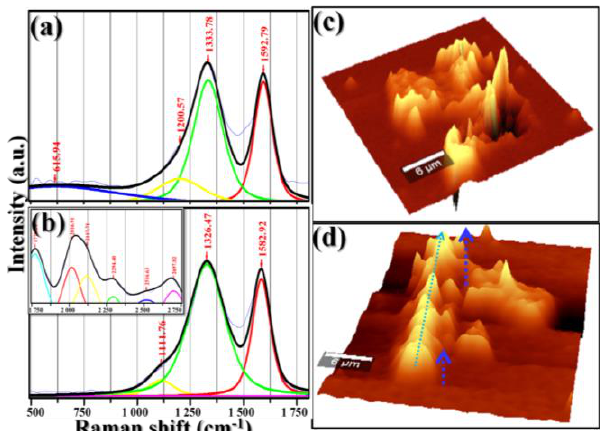
Figure 4. Raman spectrographs recorded for ( a ) GLNRs and ( b ) HSR GLNRs (inset 2D peaks), corresponding confocal Raman imaging ( c , d ), (scan area 40 × 40 µm 2 ) arrows indicate the shock wave-induced redistribution of D and G zones.